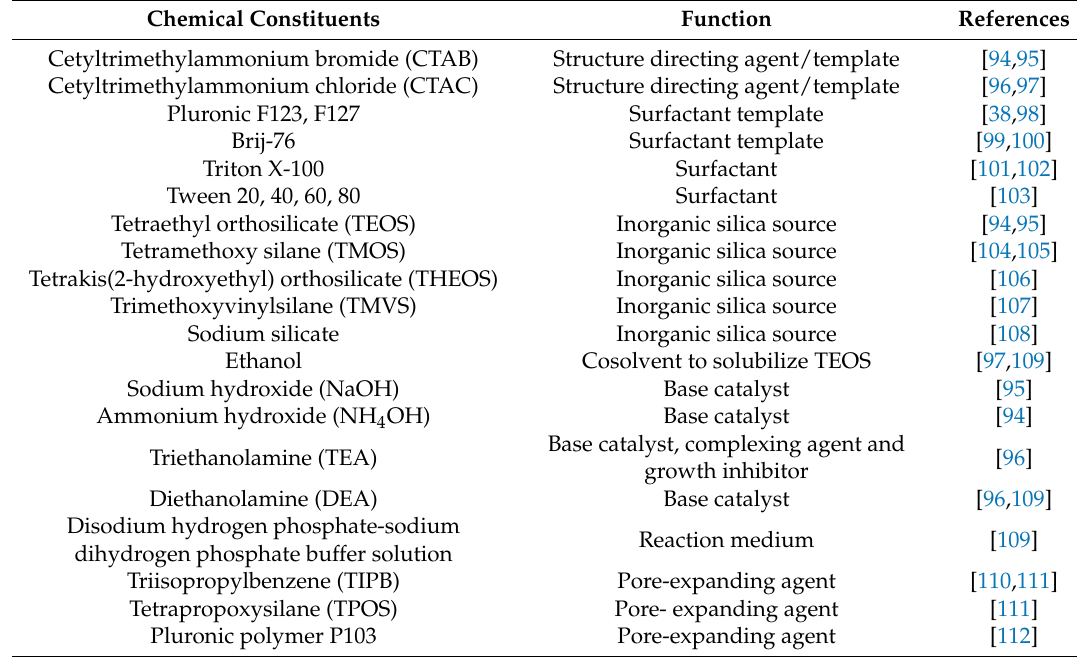
Table 3. List of commonly used chemicals in the synthesis of